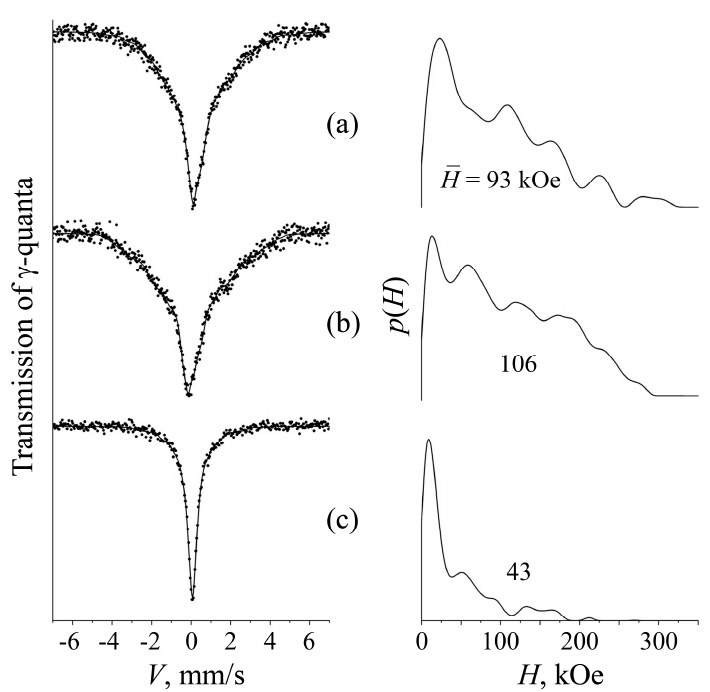
Figure 18. Spectra, the distributions p ( H ), and magnitudes of H for the alloy Fe 63.5 Ni 33.4 Ti 3.1 . Treatment (state): ( a ) annealed at 923 K for 0.5 h (aged); ( b ), ( c ) aged and irradiated by fast neutrons with a fluence of 10 20 cm − 2 at 340 K and 530 K, respectively.